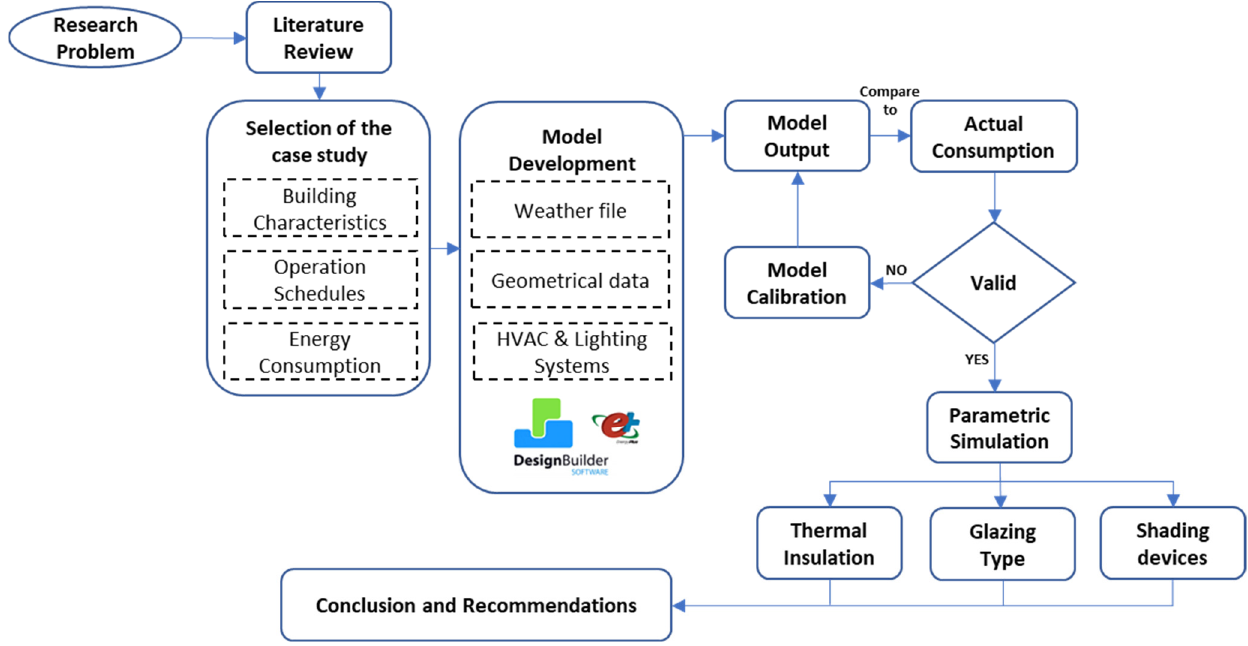
Figure 2. Schematic summary of the research methodology.